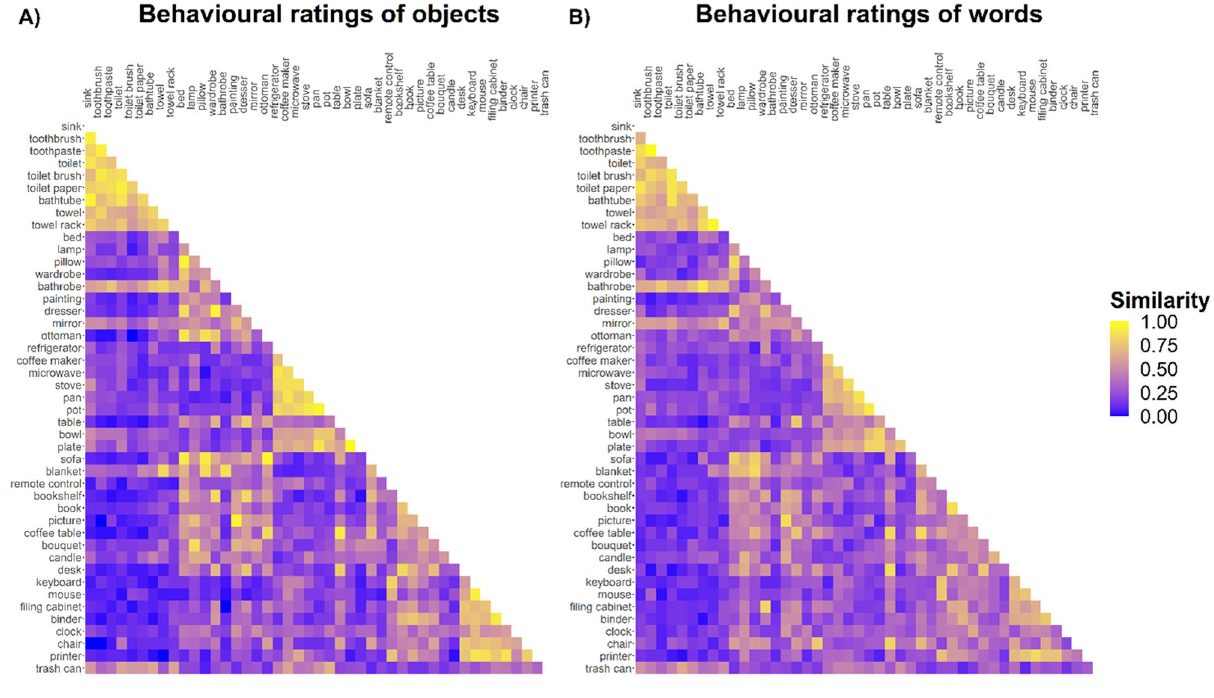
Figure 4. Representational (dis)similarity matrices (RDMs) for the ratings collected in Exp 1 (object pictures, A ) and Exp 2 (words, B ). Cells represent pairwise similarity ratings averaged across all the triplets where the pair was present. Every pair was presented in a triplet with all the other remaining objects (“context object”), and it was judged either as similar (1) or dissimilar (0), so that in the RDMs pairwise similarity spans from 0 (never judged as similar) to 1 (always judged as